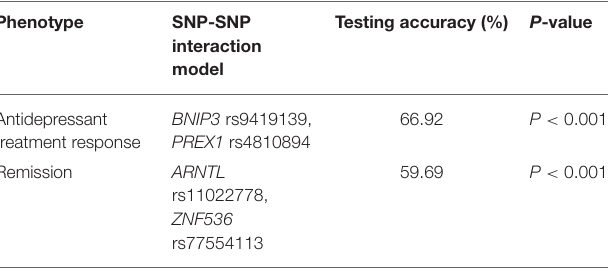
TABLE 6 | SNP-SNP interaction models identified by the GMDR method with adjustment for age, sex, and